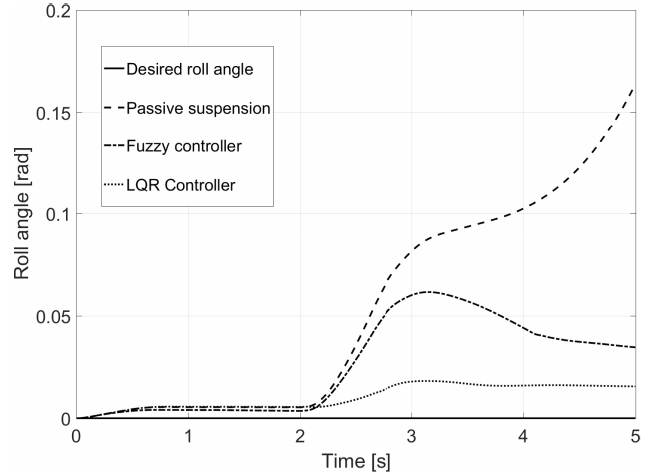
Figure 7. Roll angle for Test